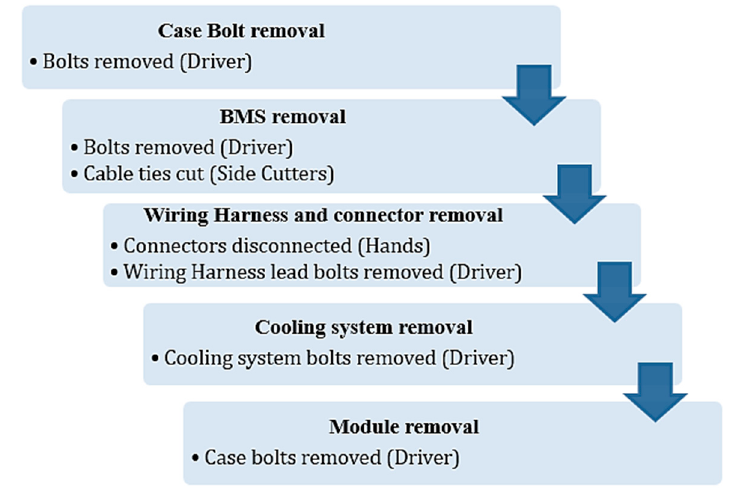
Figure 1. Disassembly process diagram of a battery pack by technician.